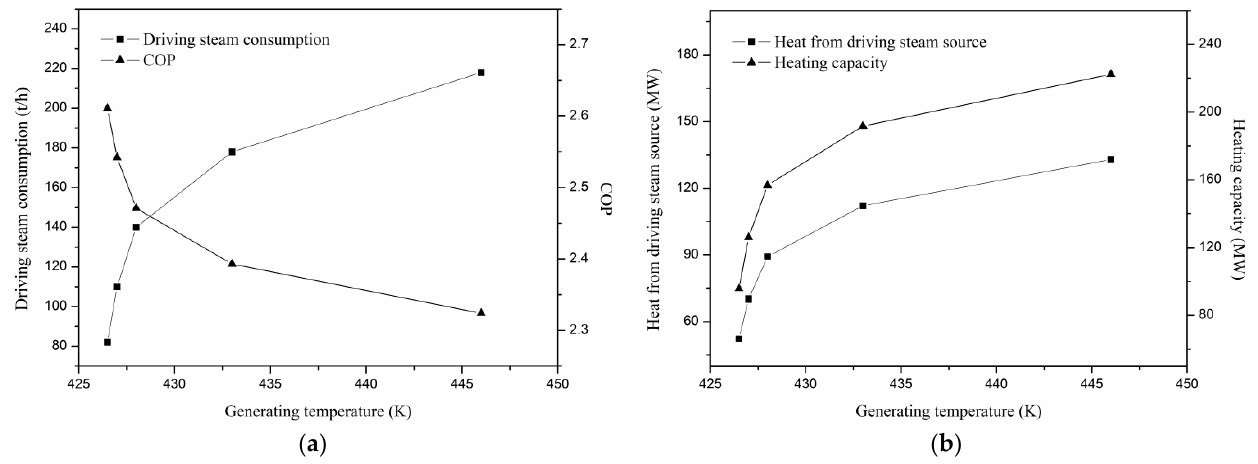
Figure 4. Effect of generating temperature on different parameters: ( a ) driving steam consumption and COP; ( b ) heat from driving steam source and heating capacity.